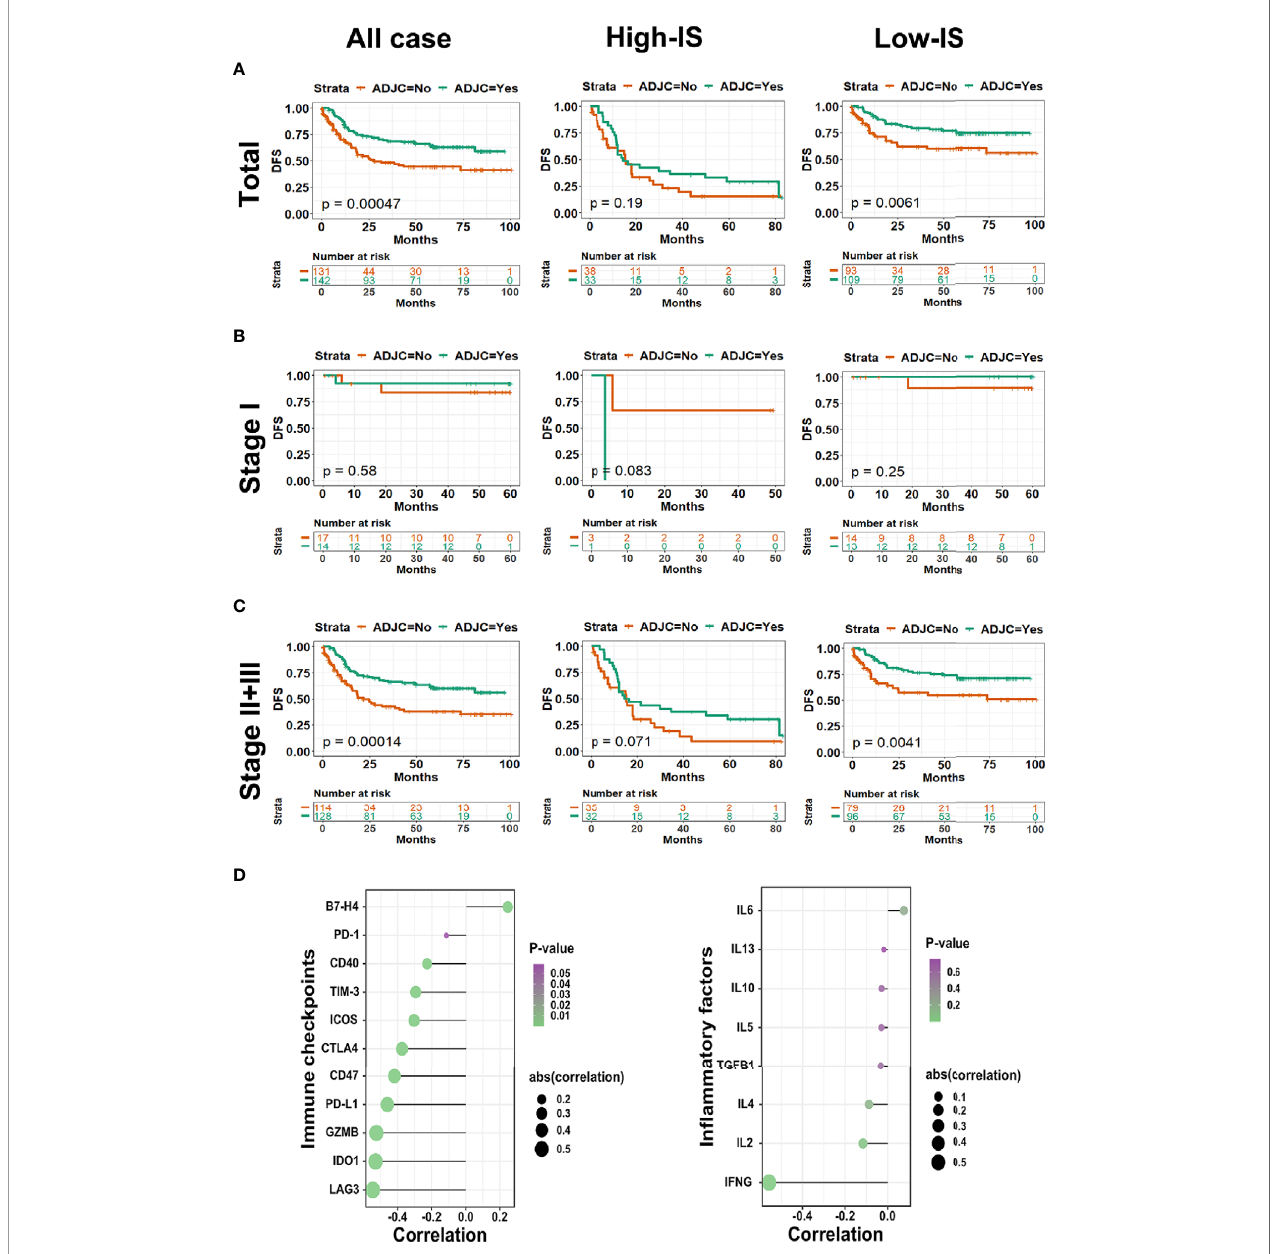
FIGURE 5 | Comparing adjuvant chemotherapy bene fi t by DFS in total and TNM stage subgroups. Kaplan-Meier curves of (A) total cohort, (B) stage I and (C) stages II and III patients with GC strati fi ed by the receipt of adjuvant chemotherapy; (D) Bubble diagrams describing the association between IS value and immune checkpoint regulators (left pane) and in fl ammatory cytokines (right pane). Bubble size represents the degree of correlation, bubble color denotes P-value. DFS , disease free survival; GC , gastric